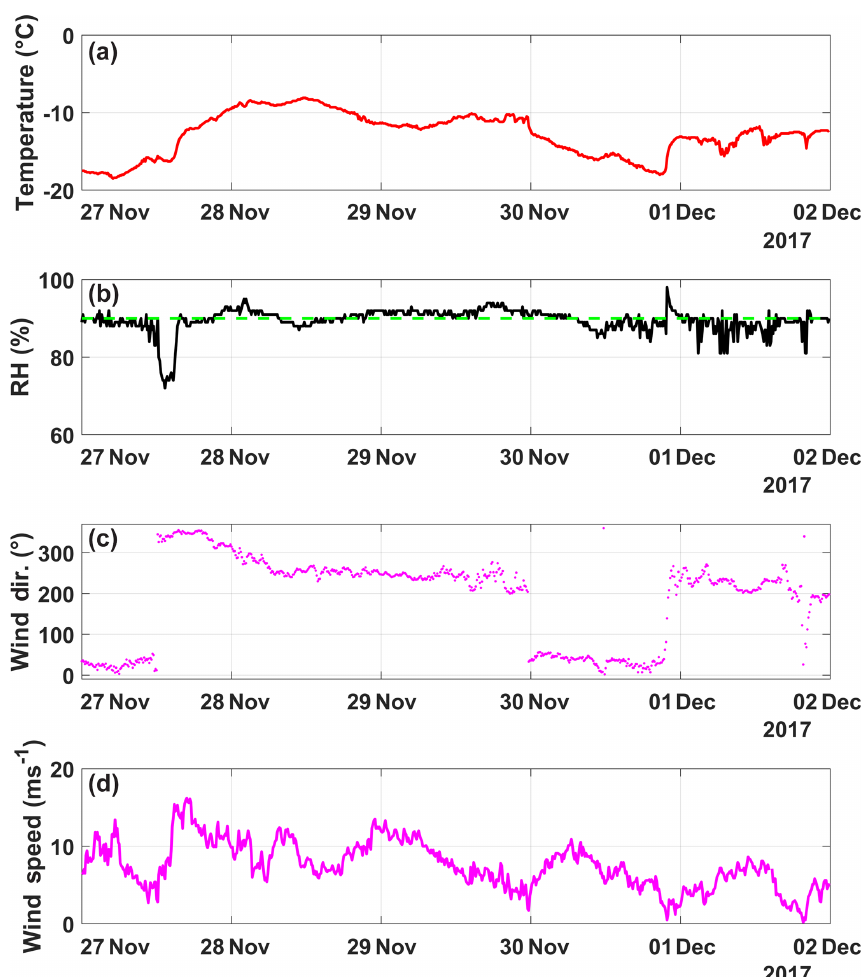
Figure A7. (a) Temperature ( ◦ C), (b) humidity (%), (c) wind direction ( ◦ ) and (d) wind speed (ms − 1 ) as a function of date, spanning from 27 November to 2 December (in UTC). The humidity when cloud is present at SBO (90%) is shown (dashed green